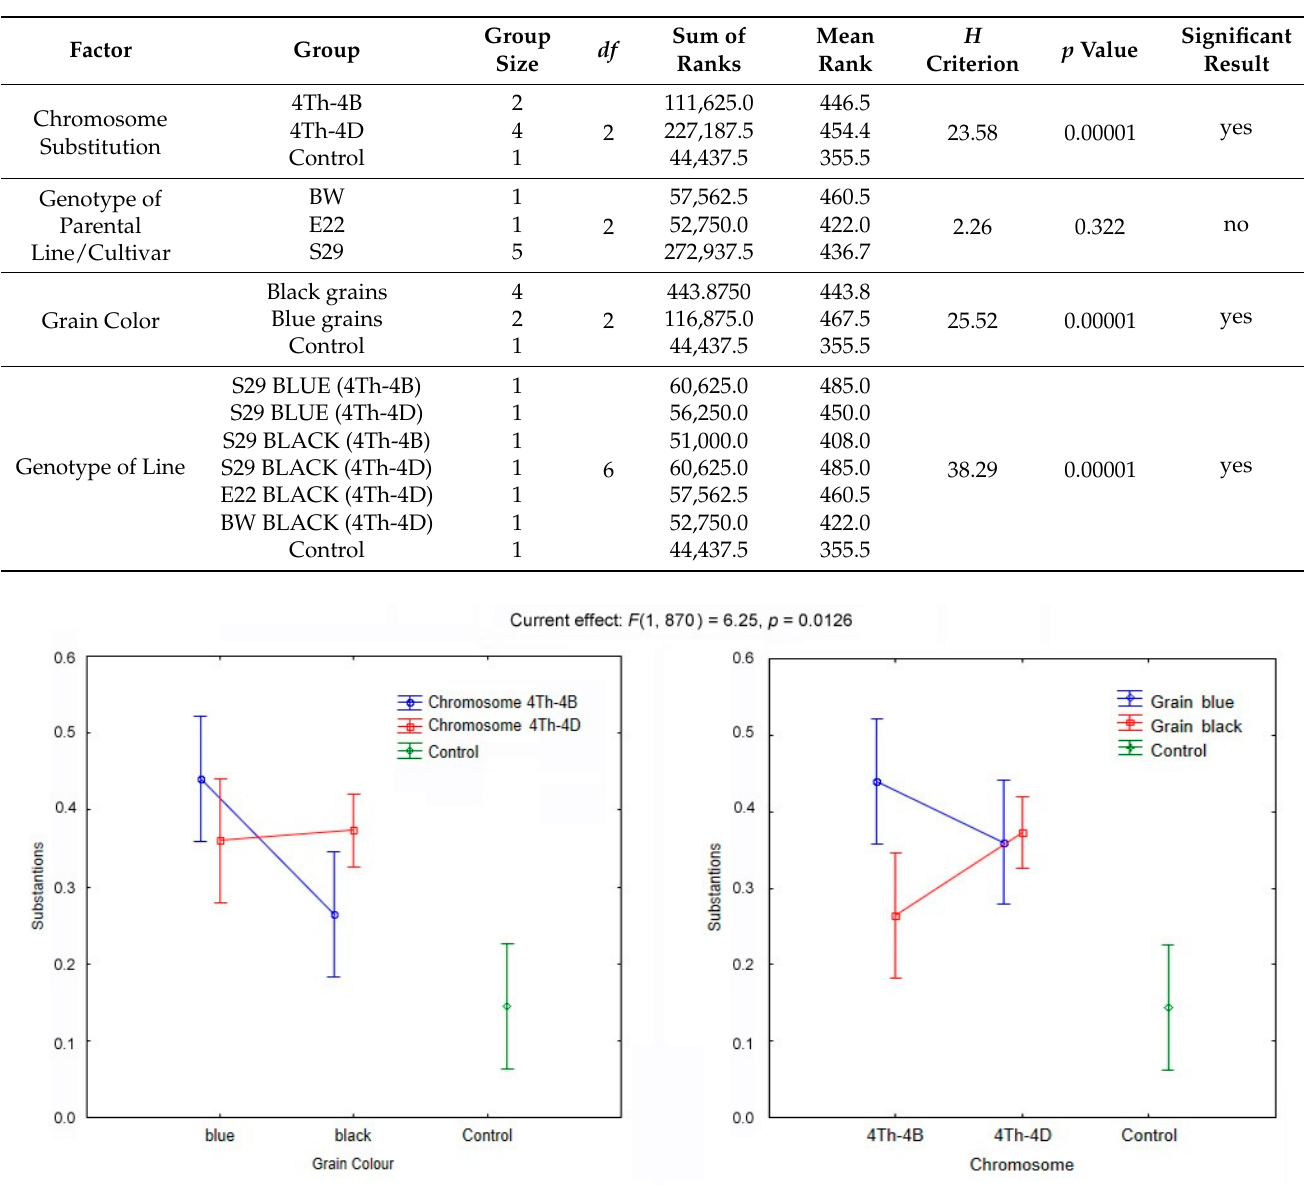
Table 2. Effects of various factors on the diversity of phenolic and nonphenolic compounds in the seven wheat lines according to the Kruskal-Wallis H test (i.e., one-way ANOVA on ranks; df : degrees of freedom).